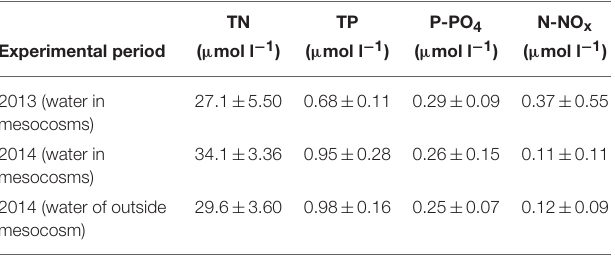
TABLE 3 | Total nitrogen (TN), total phosphorus (TP), phosphates (P-PO 4 ), and nitrites + nitrates (N-NO x ) content (mean of the experimental period ± standard deviation, SD) of the water in mesocosm 2013 ( n = 30), 2014 ( n = 33) and water of outside mesocosm 2014 ( n =